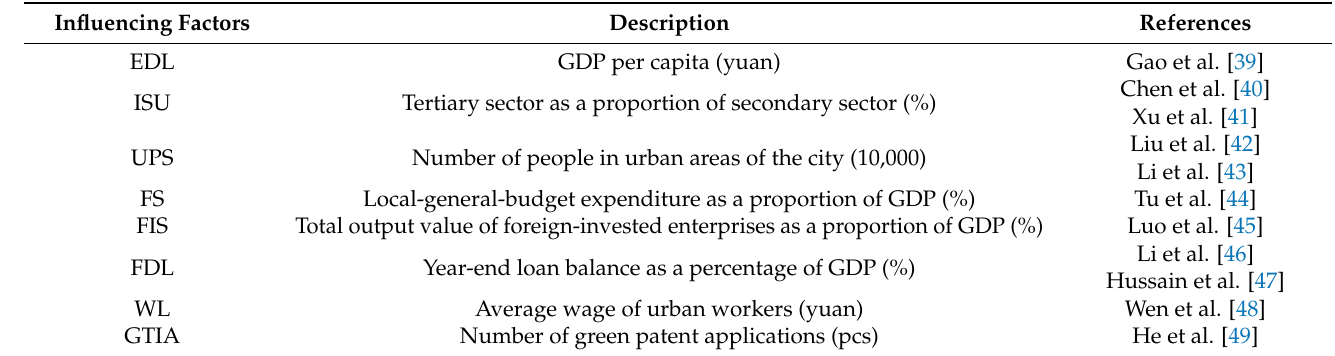
Table 5. Influencing factors of